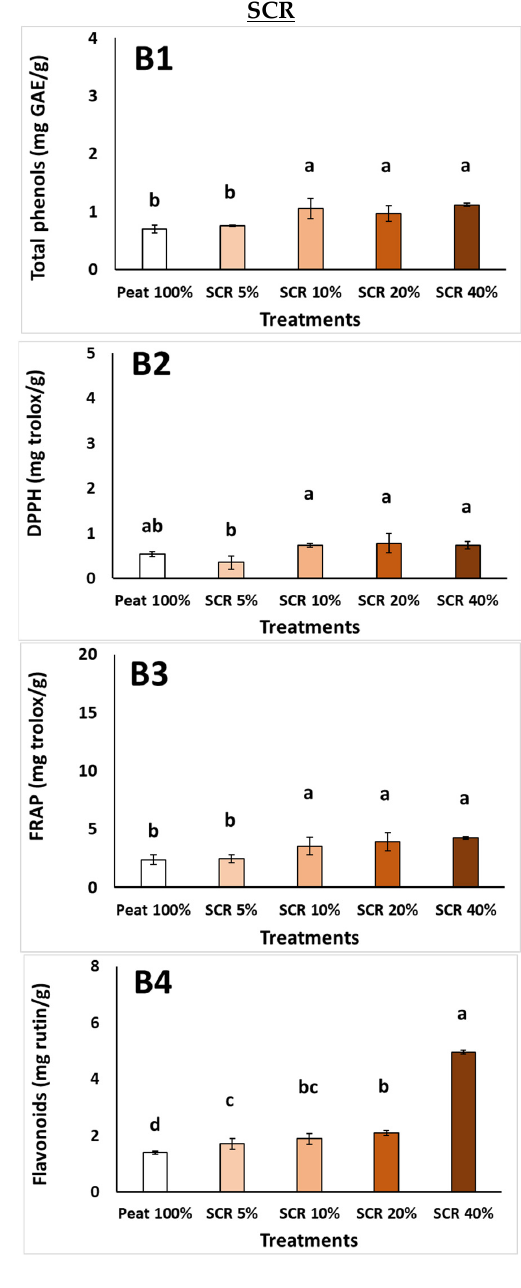
Figure 1. Effects of growing media (peat, O. dubium residue—ODR, and S. cypria residue—SCR) on total phenols (mg GAE/g fw), antioxidant activity (DPPH, FRAP: mg trolox/g fw), and flavonoids (mg rutin/g fw) in sowthistle plants (ODR: A1 – A4 ; SCR: B1 – B4 ). Values are mean ± SD ( n = 6). Mean values followed by the same le tt er do not di ff er signi fi cantly at p ≥ 0.05, according to Duncan’s Multiple Range Test.